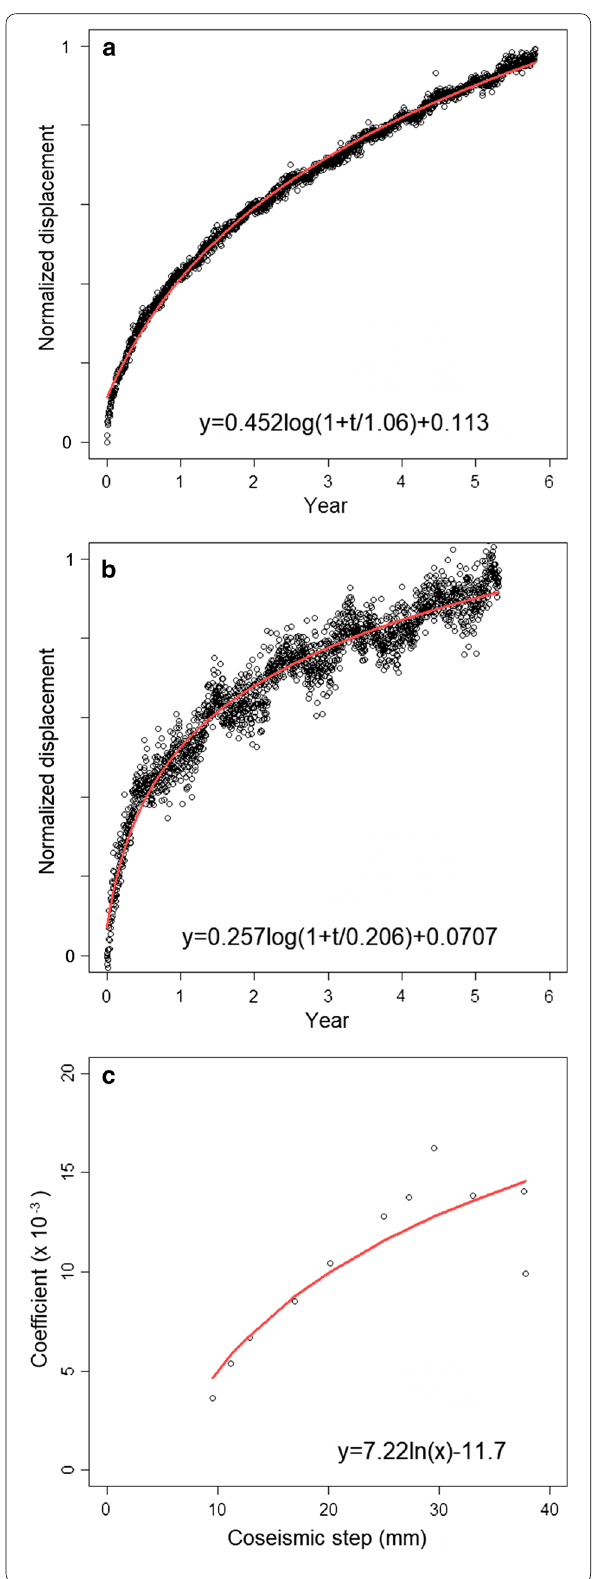
Fig. 3 Estimation of postseismic displacements. a Time series of EW components of postseismic deformation from the 2011 Tohoku earthquake, normalized with respect to the maximum of 10 stations within area X in Fig. 1. b Time series of NS components of postseismic deformation from the 2004 earthquake off Kii Peninsula, normalized with respect to the maximum of a set of eight selected stations. c Cor- relation between the coseismic steps from the 2004 earthquake off Kii Peninsula and the amplitude coefficient of the fitted logarithmic func- tion for points between 135.5°E and 136.5°E. The red line in all plots is a curve fitted by a logarithmic function